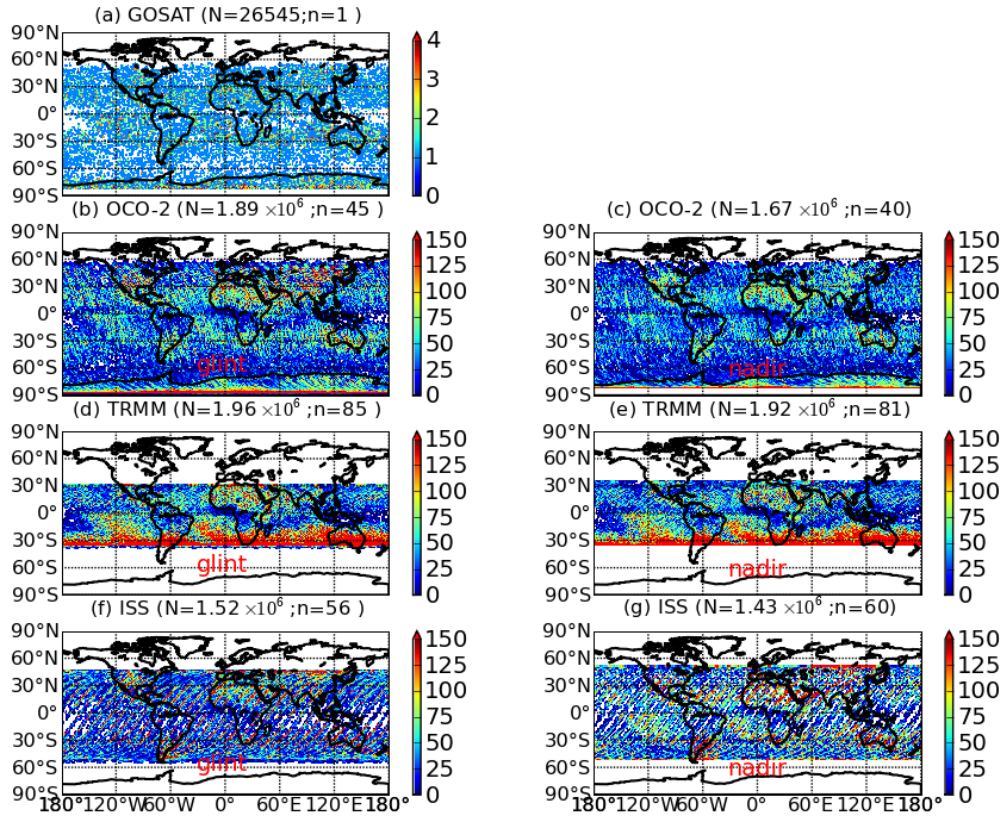
Fig. 3. The number of cloud- and aerosol- free scenes (AOD < 0.3) for January 2003 averaged on a uniform 1 ◦ grid for GOSAT and OCO-2 in sun-synchronous orbits, and for an OCO-2 SWIR spectrometer in the NASA TRMM and ISS orbits. For GOSAT we consider the sum of nadir and glint measurements, reflecting its current operational mode. N is the monthly global total clear-sky measurements, and n is mean number of clear-sky measurements for each grid box with measurements. See Table 1 for details about the orbit and instrument characteristics.